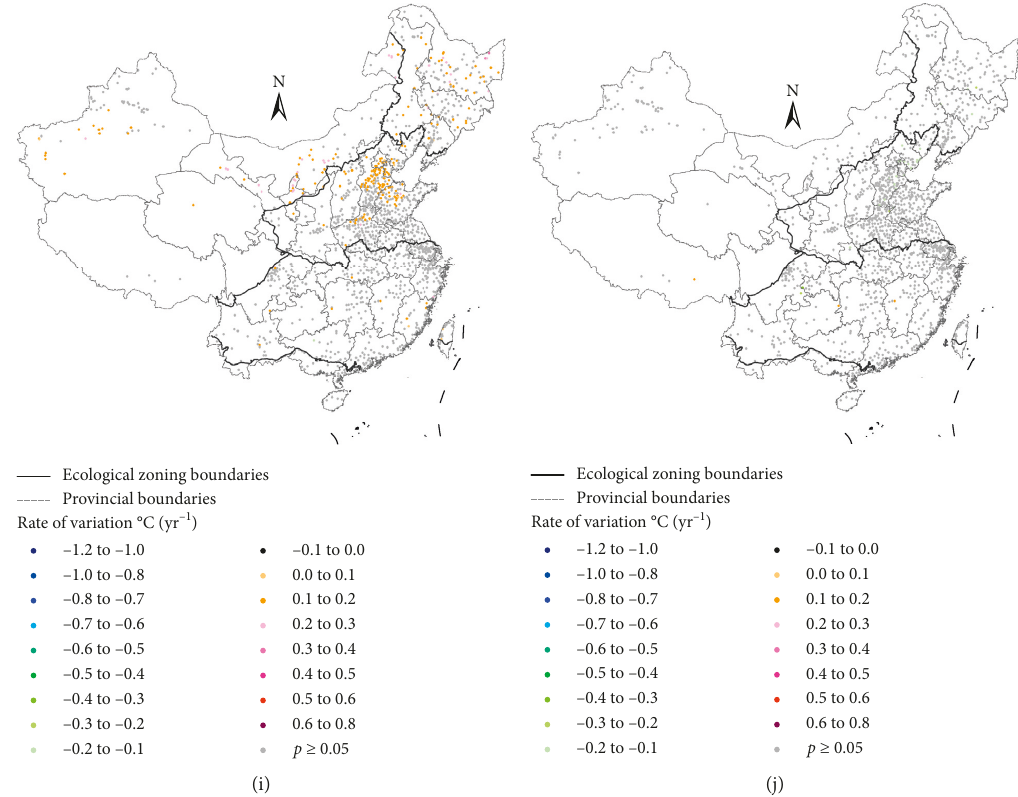
Figure 4: Spatial distribution of the annual and seasonal change rates of LSTs in urban regions during the daytime and night-time from 2003 to 2013 in the five environmental regions of China: (a–e) the results during the whole year, winter, spring, summer, and autumn daytime, respectively; (f–j) corresponding values during night-time. (a) Annual day. (b) Winter day. (c) Spring day. (d) Summer day. (e) Autumn day.